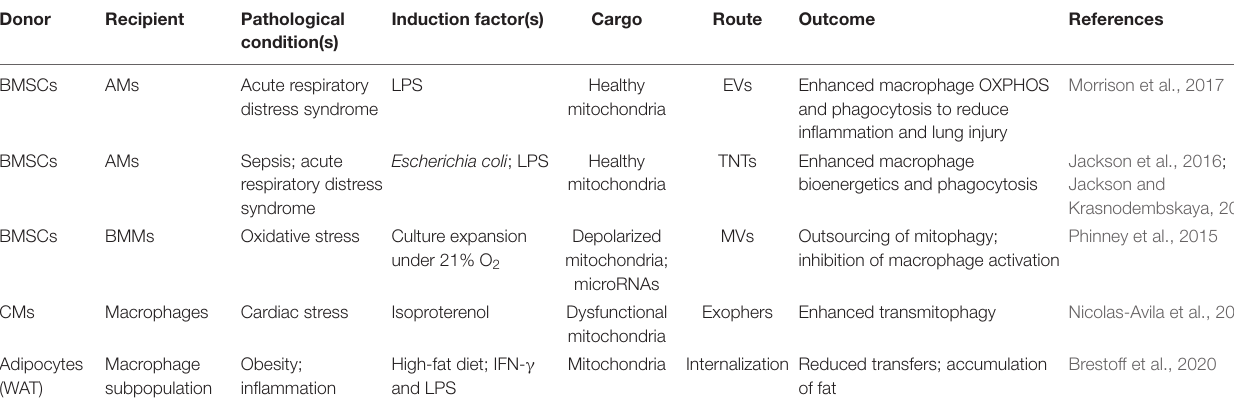
TABLE 2 | Intercellular mitochondrial transfer in macrophages under pathological